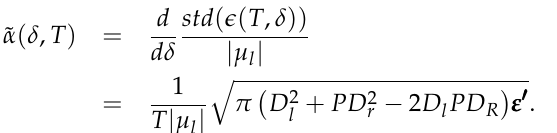
The horizontal dotted blue line shows the value of α , which is obtained directly from the trace via the sliding window method described in Section 4.2. The convergence behavior for increasing N shows that a number of states N ≥ 25 are required for the model to converge. This actually depends on the discretization approach adopted.